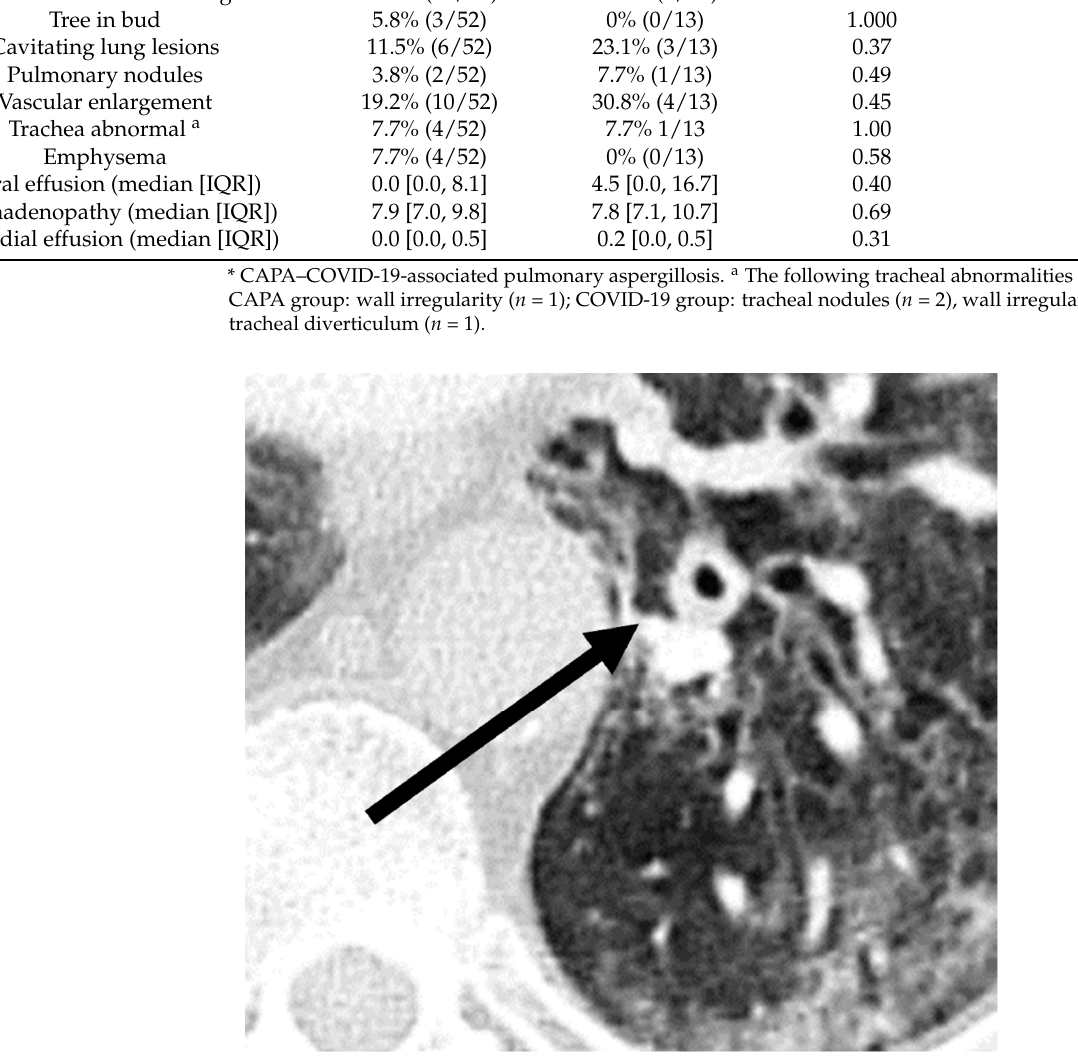
Figure 3. Imaging example of bronchial wall thickening (arrow) in a patient with probable COVID- 19-associated pulmonary aspergillosis (CAPA). CT was performed 10 days after symptom onset on the day of the CAPA diagnosis. The T/D ratio (wall thickness (T) divided by the total diameter of bronchus (D)) was 0.32 in this case. Table 2. Comparison of additional findings between patients with COVID-19 and with CAPA .